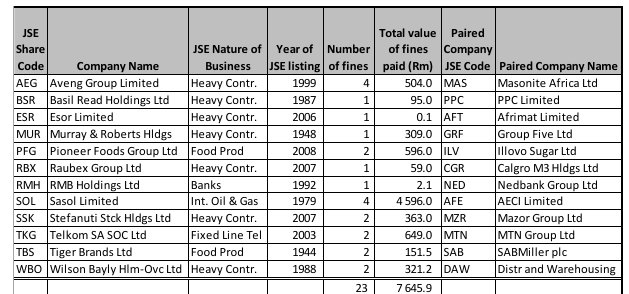
Table 1: Descriptive details of the